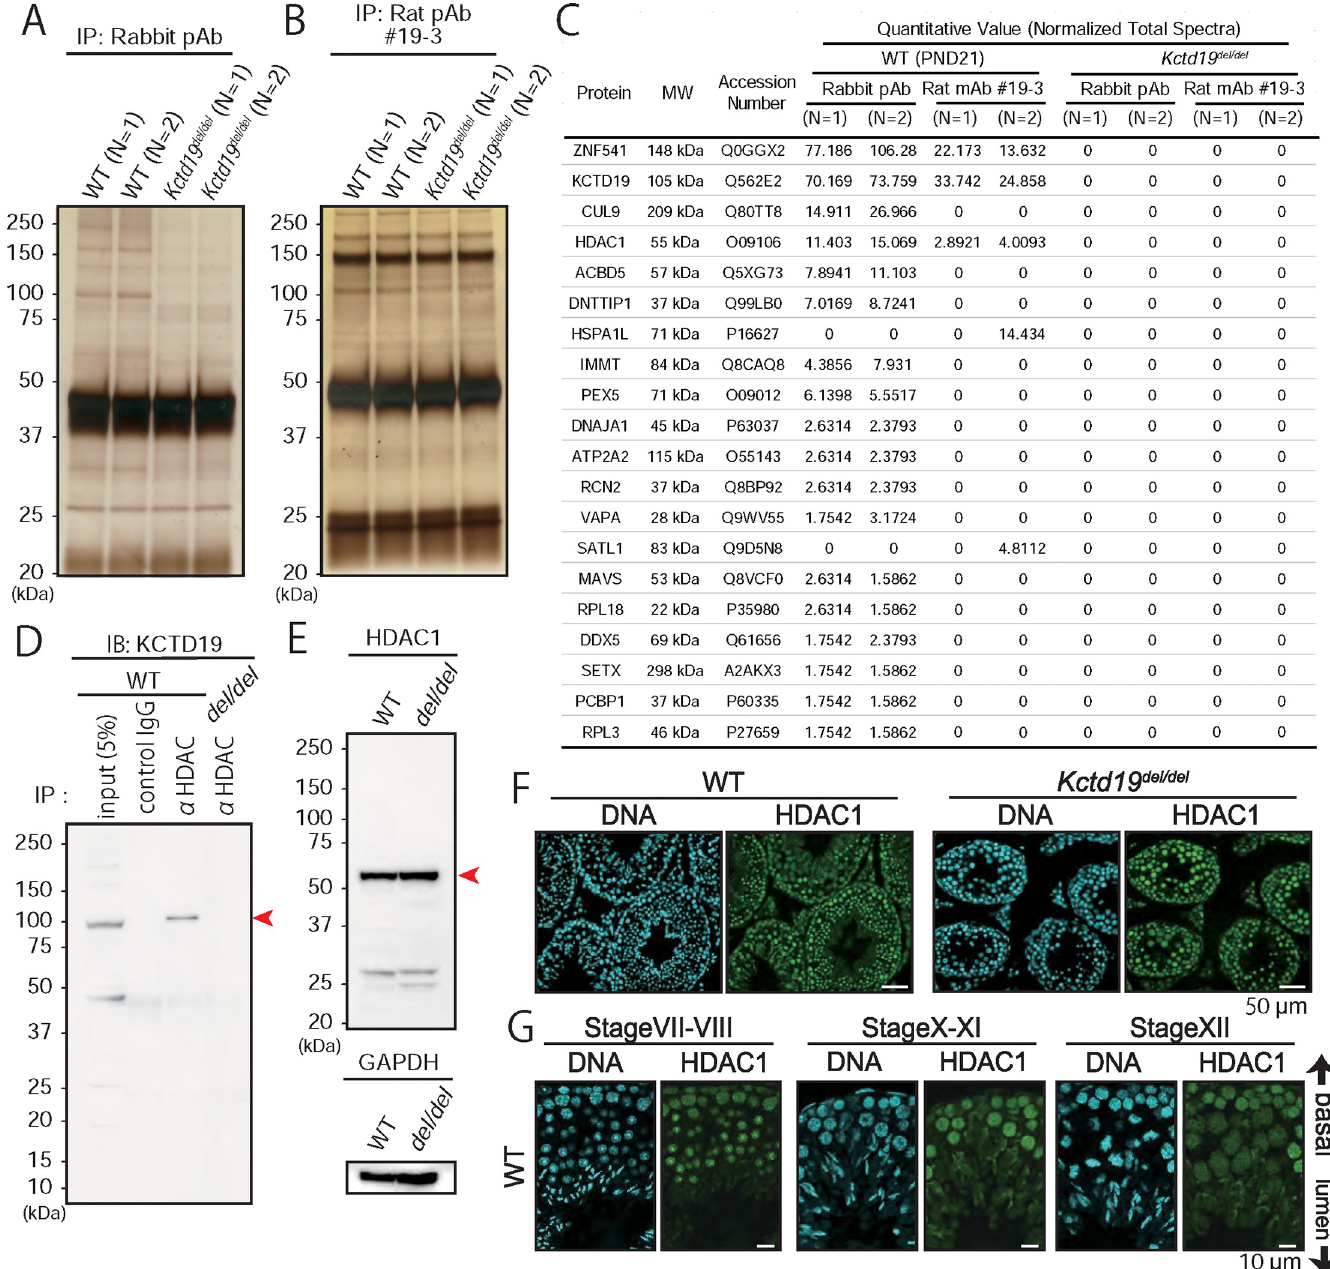
PLOS Genetics | https://doi.org/10.1371/journal.pgen.1009412 May 7,